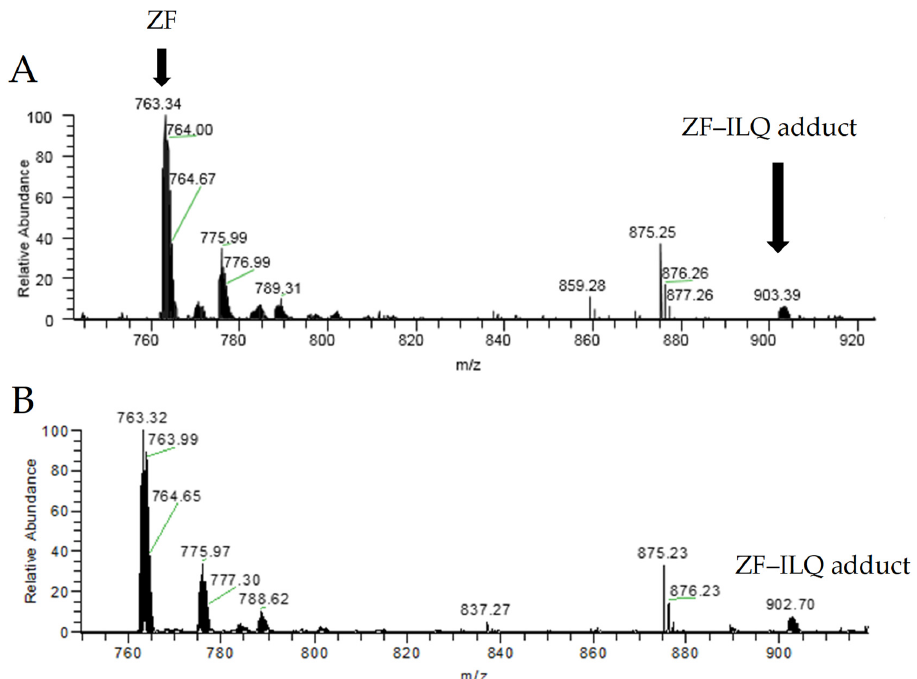
Figure 4. ESI ‐ MS spectra of the reaction mixture between ZF and ILQ. ( A ) 10 μ M of zinc finger were incubated with 30 ‐ Figure 4. ESI-MS spectra of the reaction mixture between ZF and ILQ. ( A ) 10 µ M of zinc finger were μ M ILQ for 15 min. ( B ) 10 μ M of zinc finger were incubated with 60 ‐μ M ILQ for 15 min. incubated with 30- µ M ILQ for 15 min. ( B ) 10 µ M of zinc finger were incubated with 60- µ M ILQ for 15 To monitor the species formed at different time points, the reaction mixture was an ‐ alyzed by ESI ‐ MS at 1:3 for 15 min, 2h and 5 h, respectively. As shown in Figure S4, the species formed at different time points are the same, and the relative intensities of the important species are similar. These results were consistent with the kinetic results from the fluorescence analysis. Therefore, the immediate noncovalent binding mode between ILQ and zinc finger was confirmed. Similar results were observed for CUR, as shown in Fig ‐ ure S7. The species observed were identified by high ‐ resolution mass spectrometry. The the ‐ oretical and experimental spectra are shown in Figures S5 and S8, and the m/z and isotope pattern are consistent between the theoretical and experimental results. The observed spe ‐ cies are summarized in Table 1. The major species are zinc finger and the noncovalent adduct of zinc finger with ILQ, which is also the case for CUR, as shown in Table 1. At the same time, a covalent adduct of an oxidized peptide with ILQ was also observed as a minor species, while the covalent species was not observed for CUR. These results showed that noncovalent recognition will gradually induce covalent binding. Thereafter, we suggested that the possible mechanism was as follows: firstly, the mol ‐ ecule recognizes and binds NC noncovalently; in the second step, the ejection of zinc from the noncovalent adduct deprotects the cysteine amino acid in zinc finger; in the final step, the oxidation of cysteine is induced by the unsaturated keto group of ILQ. For CUR, its activity is lower than that of ILQ; thus, we did not observe the dissociation of Zn. The inhibiting activity of ILQ towards the binding between the zinc finger peptide and nuclear acid should be tested in the future.